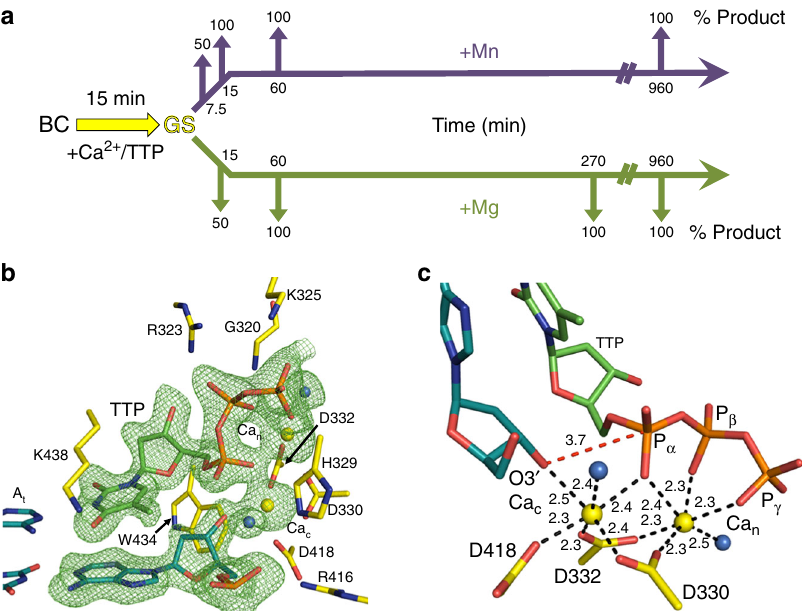
Fig. 2 Time-lapse crystallography and the structure of the ground state pre-catalytic ternary complex of pol μ . a Soaking binary complex (BC, black ) crystals (gapped DNA/protein) of pol μ in a cryo-solution containing CaCl 2 and the incoming nucleotide (TTP) for 15 min results in formation of the Ca 2+ -bound pre-catalytic GS ( yellow ) ternary complex. Subsequent soaking of the GS in a cryo-solution at 4 °C containing 10 mM MgCl 2 ( green ) or 10 mM MnCl 2 ( purple ) initiates the reaction in the crystal. Crystals are frozen after increasing incubation times ( green and purple arrows ) and the structure of the complex is determined. b The active site of the Ca 2+ -bound pre-catalytic GS ternary complex. The incoming nucleotide ( green stick ), Ca 2+ ions ( yellow spheres ), primer terminus and templating adenine base ( cyan stick ), as well as key active site residues ( yellow stick ) are shown. The F o – F c simulated annealing omit map ( green mesh ) shown is countered at 2.5 σ . c A 90° rotation of the active site in comparison to b with metal-coordinating ligands indicated by dashes . Metal coordination is illustrated with dashed lines with distances (Å) indicated. The distance between O3 ′ and P α is shown as a red dashed